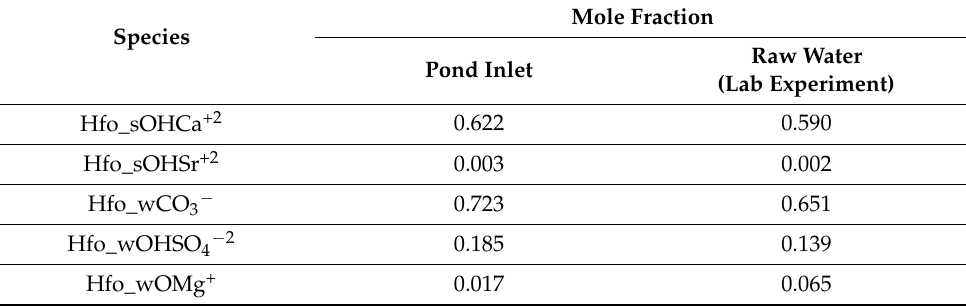
Table 7. Diffuse double-layer surface complexation model of the WTP wastewater pond inlet prior to daily brine discharge and raw water control sample from laboratory experiments. Mole Fraction Species Raw Water Pond Inlet (Lab Experiment) Hfo_sOHCa +2 0.622